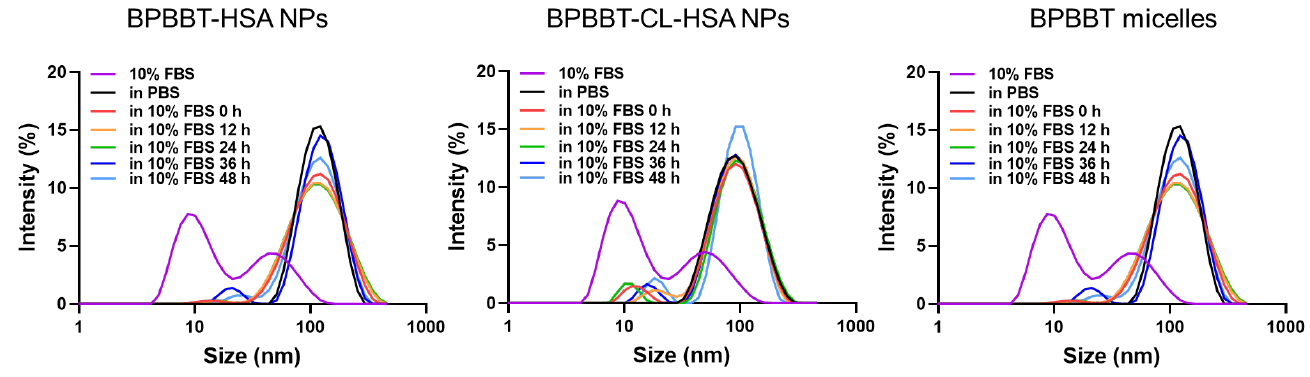
Figure 2. Size distribution of different types of BPBBT nanoparticles in PBS or in 10% FBS for different incubation times. The size distribution of 10% FBS was used as control.